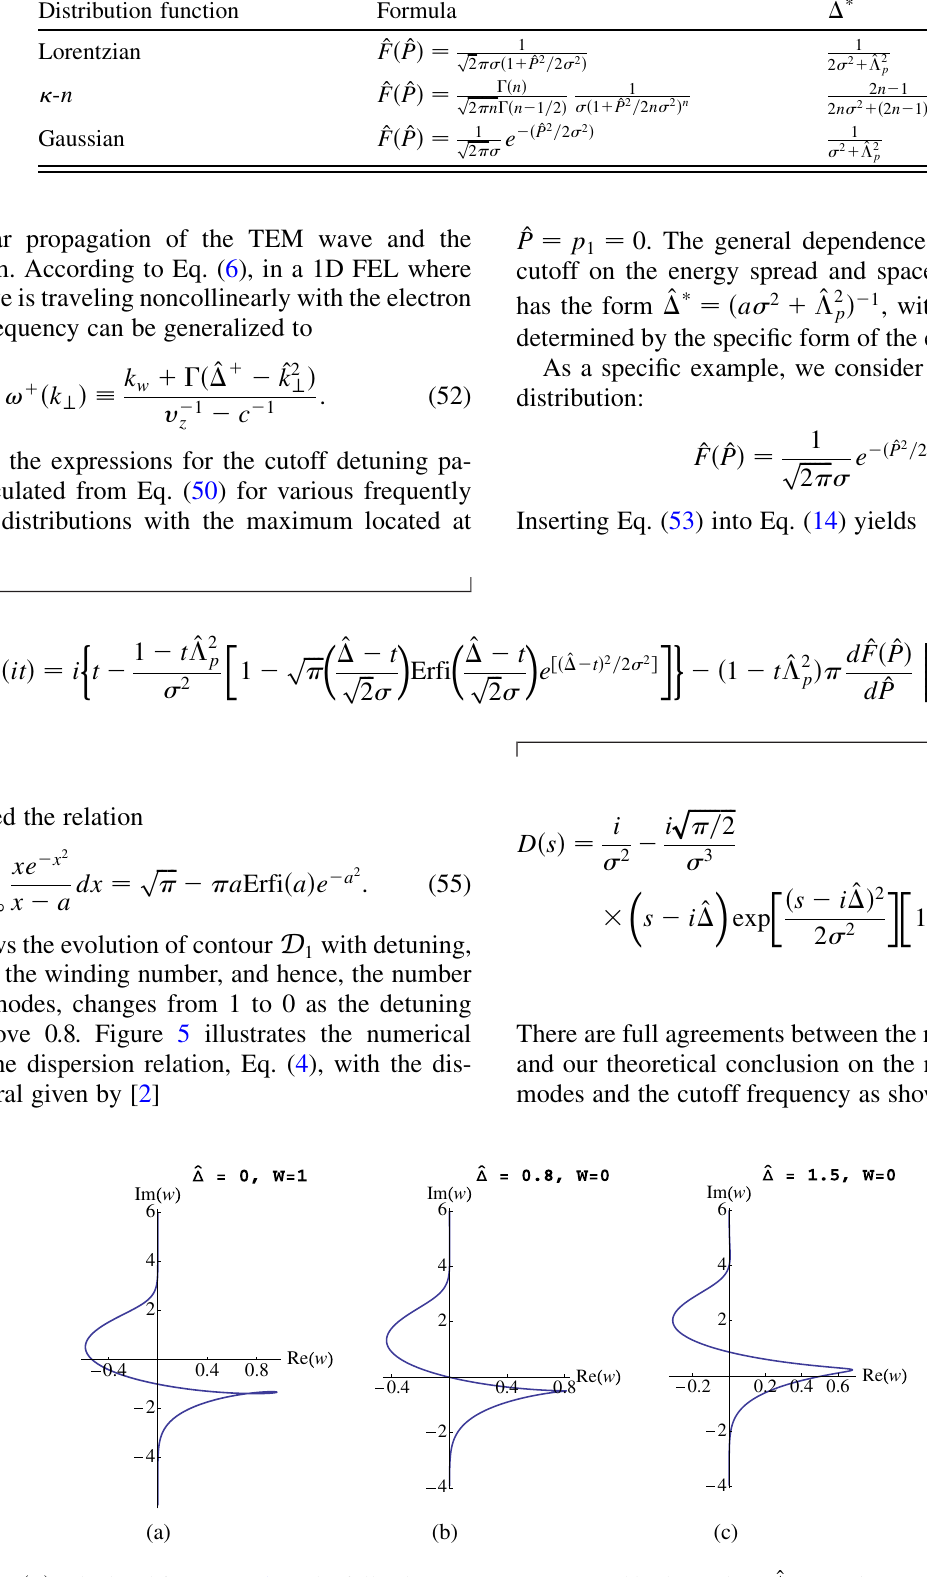
FIG. 4. Plots w ð it Þ calculated from Eq. (54). The following parameters are used in these plots: ^(cid:2) p ¼ 0 : 5 , (cid:7) ¼ 1 , and ^(cid:3) ¼ 0 ; 0 : 8 ; 1 : 5 (from left to right).